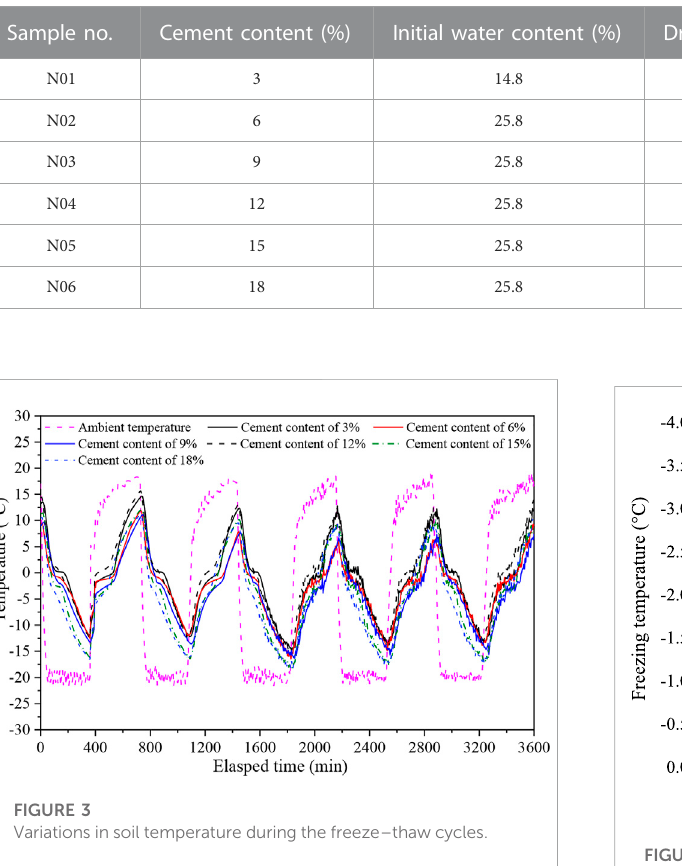
Freezing temperature of cement-stabilized soil samples with different cement